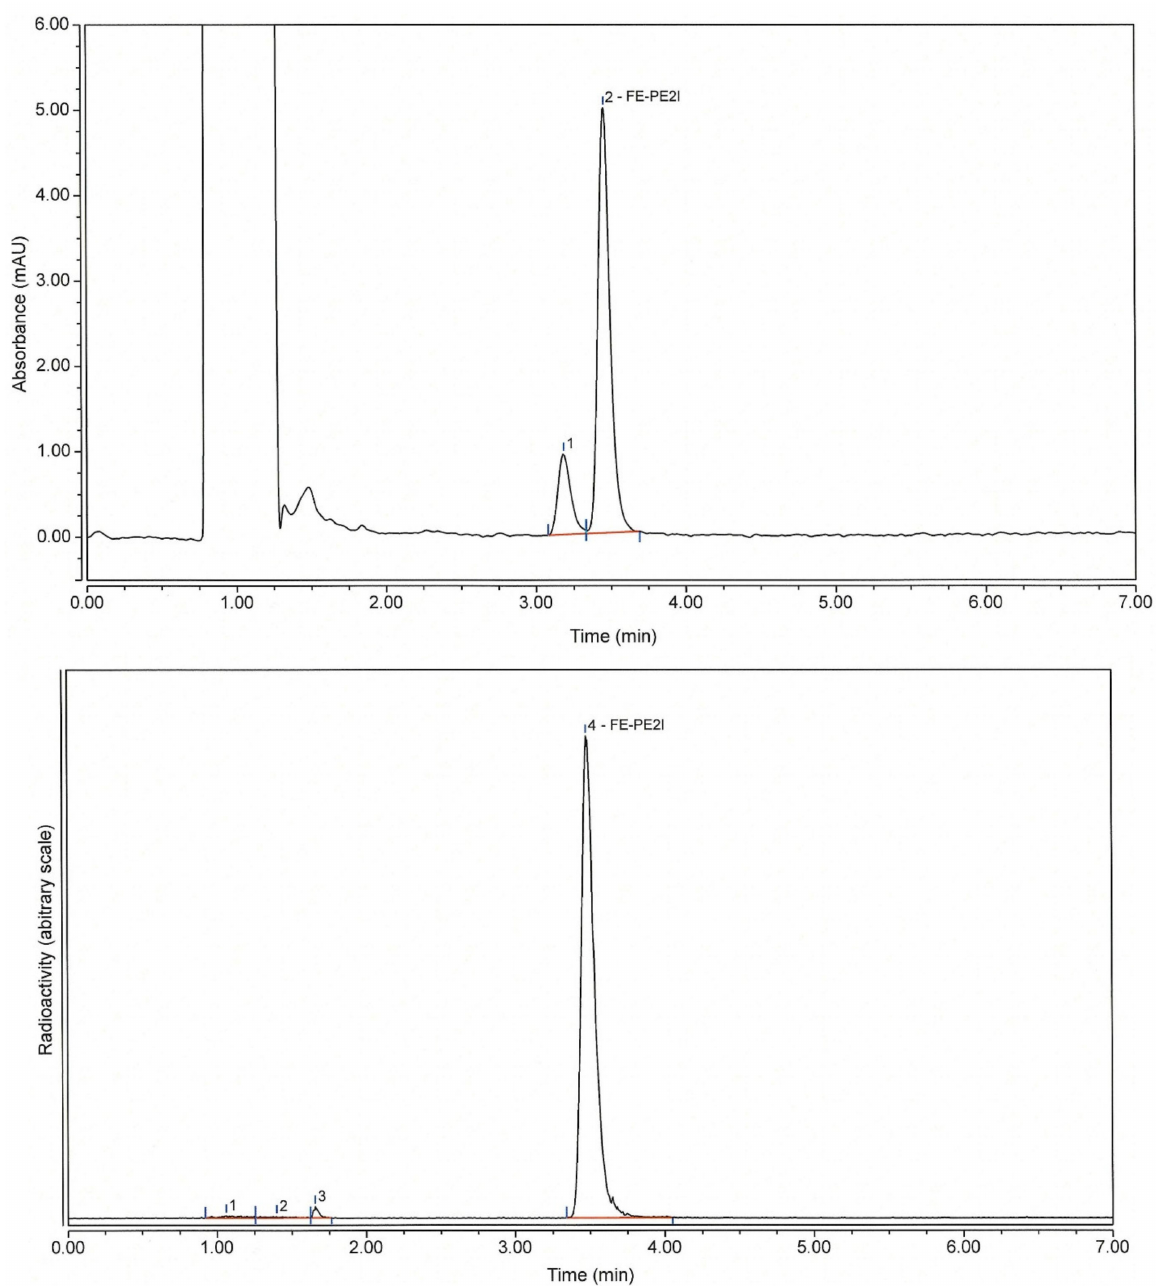
Figure 2. Analytical HPLC chromatograms of [ 18 F]FE-PE2I (UV—220 nm) ( top ) and radioactivity ( bottom